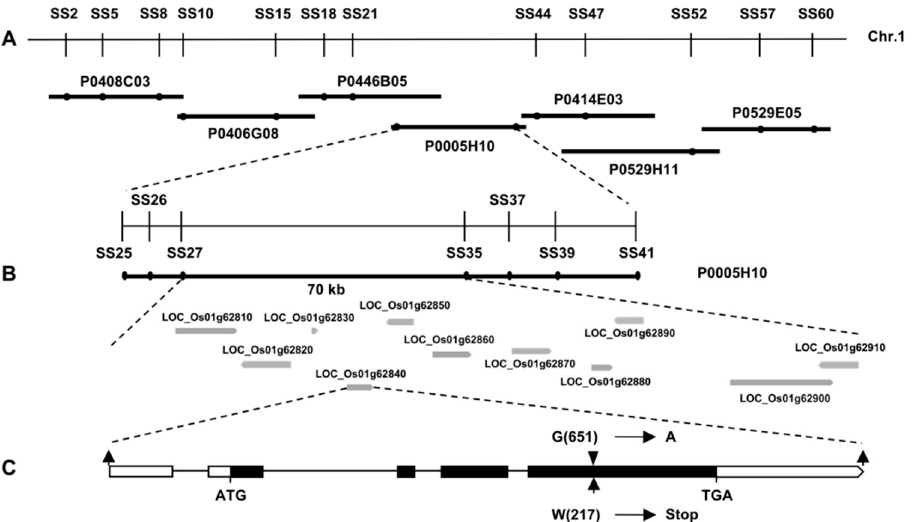
Figure 2. Map-based cloning of SS3 . ( A ) SS3 was initially mapped to chromosome 1 (Chr.1) and fine mapping was carried out with markers developed based on the sequence of BAC clone P0005H10. The SS3 locus was narrowed to a 70 kb genomic DNA region between markers SS27 and SS35. ( B ) Eleven open reading frames were located in the region. ( C ) Gene structure of the SS3 candidate LOC_Os01g62840. Start codon (ATG) and the stop codon (TGA) are indicated. Blank boxes indicate coding sequence. Arrows show mutation site of ss3 .